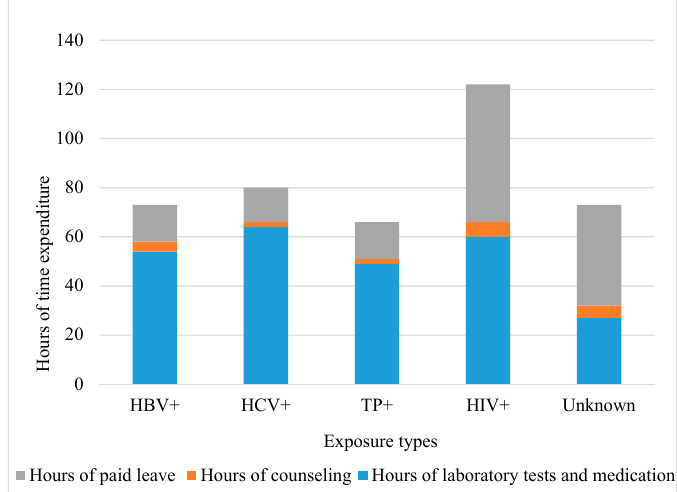
Figure 2. Time expenditure associated with occupational BBF exposure management. HIV: human immunodeficiency virus; HBV: hepatitis B virus; HCV: hepatitis C virus; TP : Treponema pallidum . The mean time was weighted by the number of staff with invasive duties.